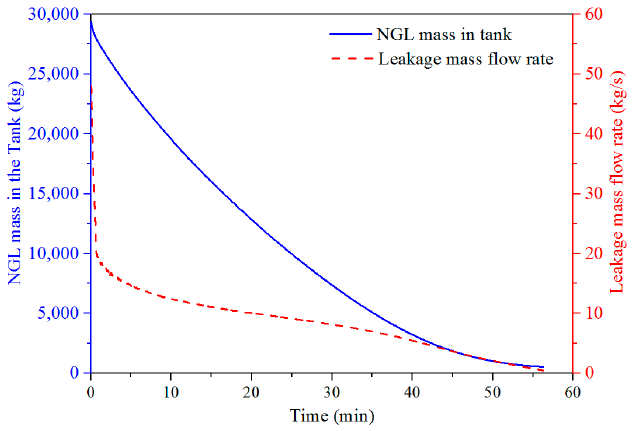
Figure 13. Changes in the leakage mass flow rate and the residual NGL mass in the tank over time.